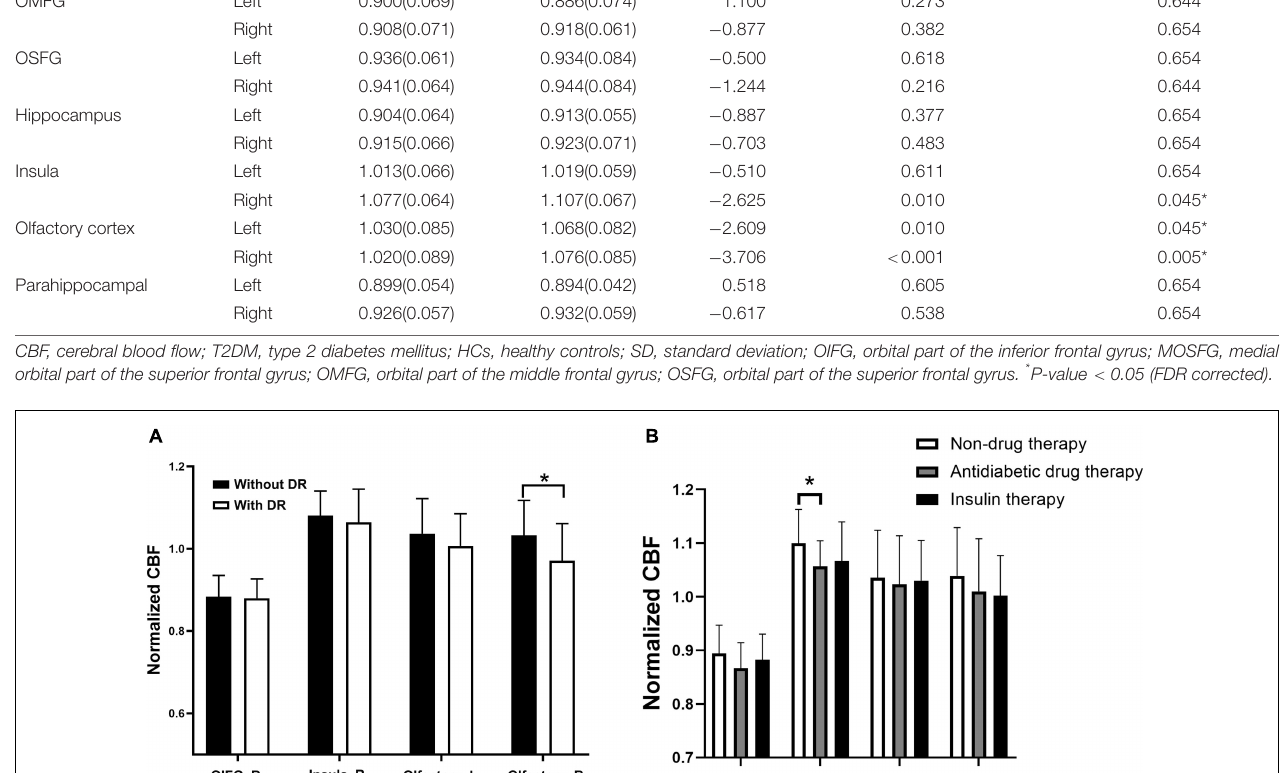
FIGURE 1 | Stratified analysis of CBF in olfactoryrelated brain regions in T2DM subgroups. (A) Subgroups with or without DR. (B) Subgroups with different treatments. * P -value < 0.05. OIFG_R, right orbital part of the inferior frontal gyrus; Insula_R, right insula; Olfactory_L, left olfactory cortex; olfactory_R, right olfactory cortex; without DR, without diabetic retinopathy; DR, diabetic retinopathy; normalized CBF, normalized cerebral blood